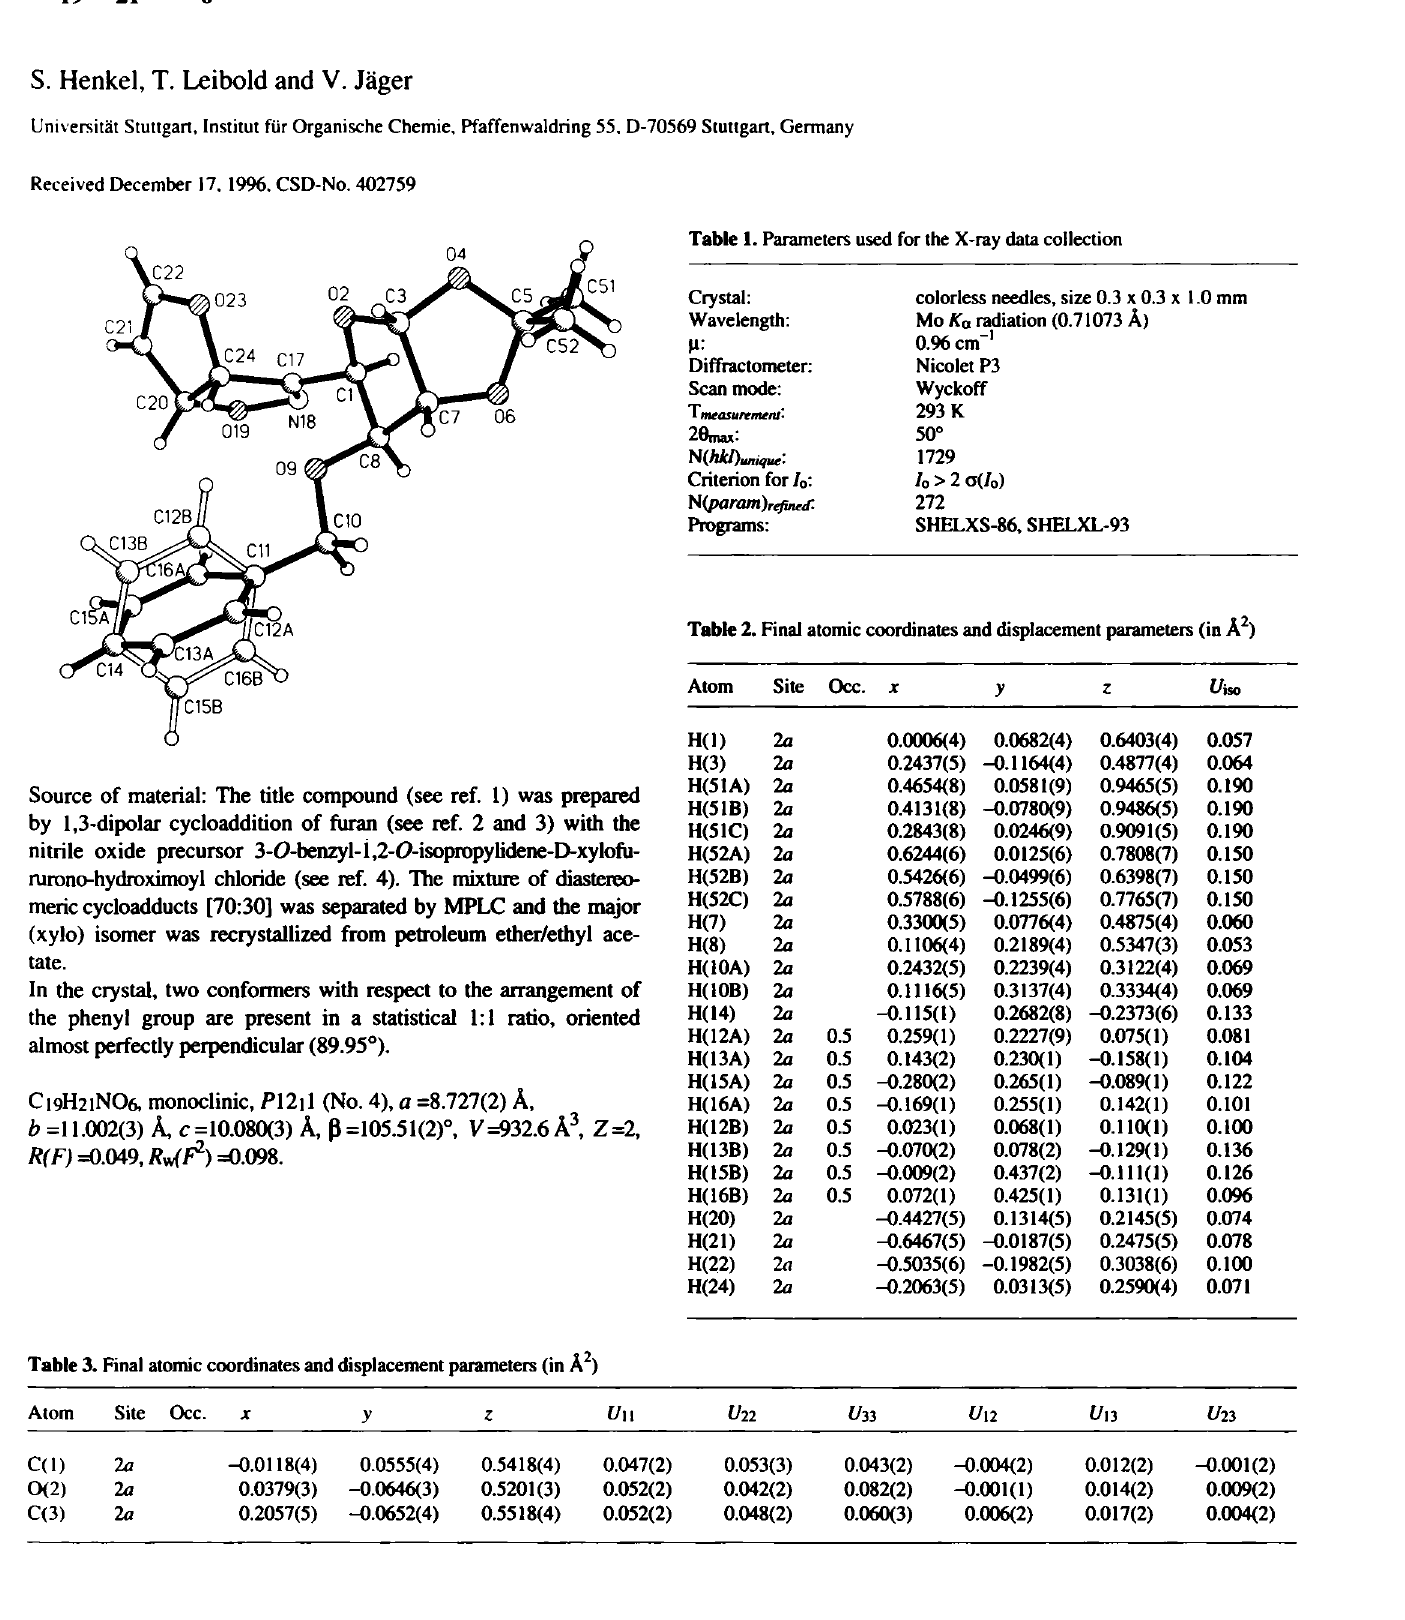
Table 1. Parameters used for the X-ray data collection Crystal: